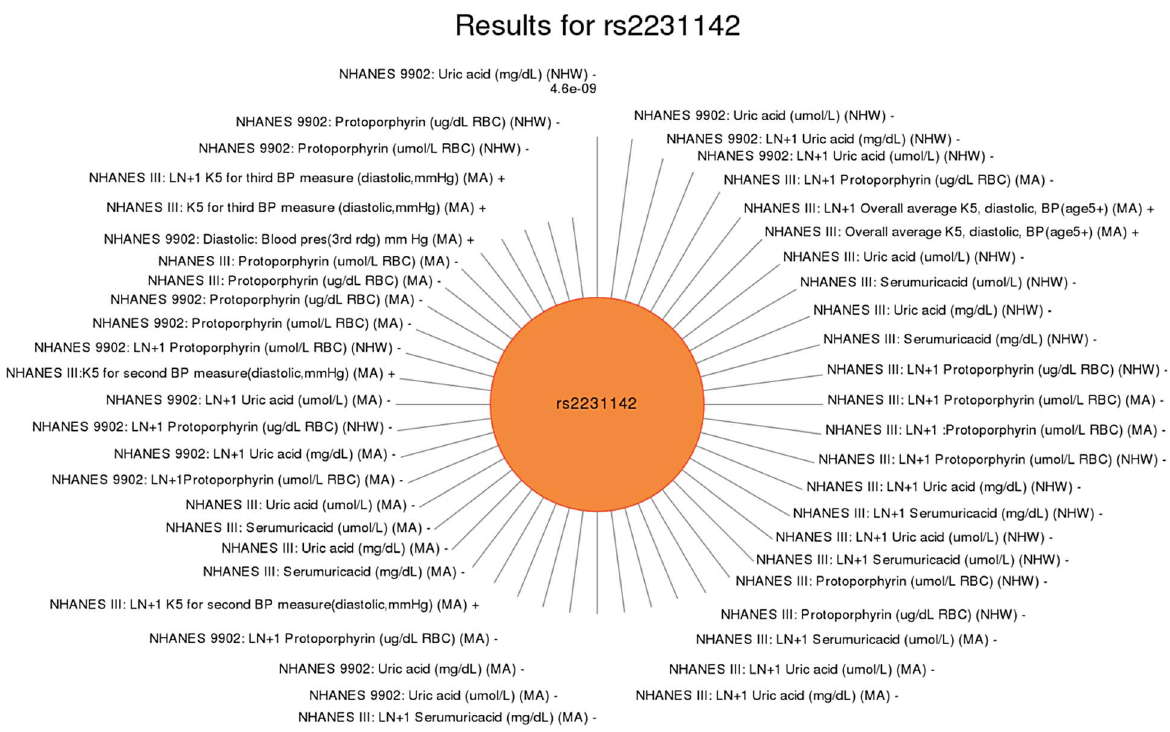
Fig. 5. Sun plot of (p , 0.01) results for ABCG rs2231142, coded allele C. This SNP has been previously reported to be associated with uric acid levels. Significant SNP-phenotype associations (p , 0.01) are plotted clockwise with the smallest p-value result at the top. The length of the each line corresponds to the –log(p-value) of each result, with the longest line representing the most significant result for this SNP, meeting our PheWAS replication criteria for inclusion. Study, transformed (LN + 1) or untransformed (none) phenotype description, self-reported race-ethnicity, and direction of effect are listed for each association. This SNP was associated with a number of phenotypes in this study including uric acid levels (as previously published) in non-Hispanic whites (NHW) and Mexican Americans (MA), protoporphyrin levels in non-Hispanic whites and Mexican Americans, and diastolic blood pressure in Mexican Americans.